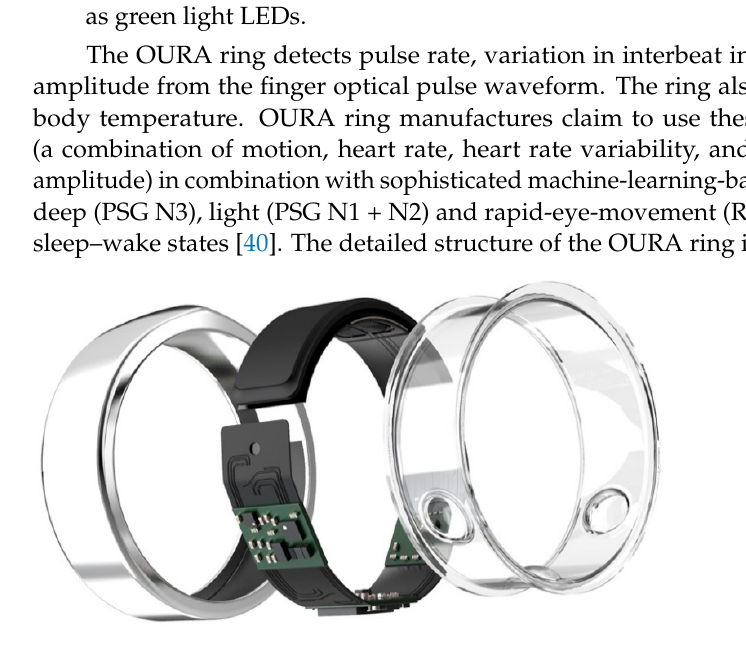
Figure 3. OURA ring detailed